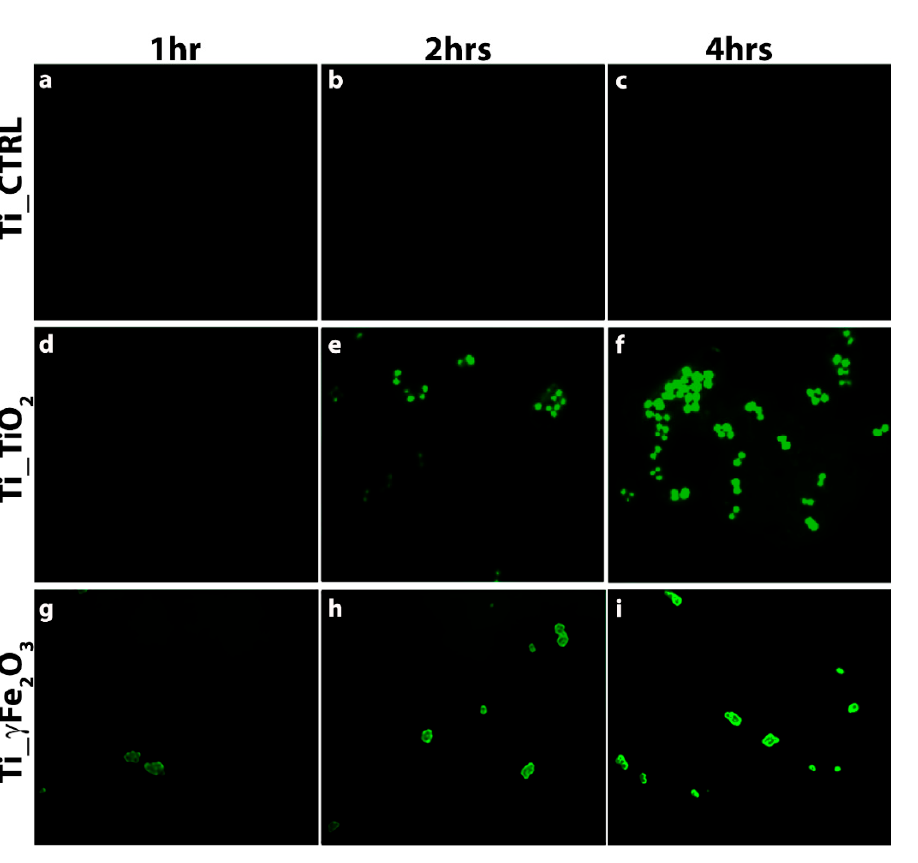
Figure 7. H 2 DCFD staining after 1, 2 and 4 h of incubation of S. aureus on Ti_CTRL ( a , b , c ), Ti_TiO 2 ( d , e , f ) and Ti_ γ Fe 2 O 3 ( g,h , i ) scaffolds.